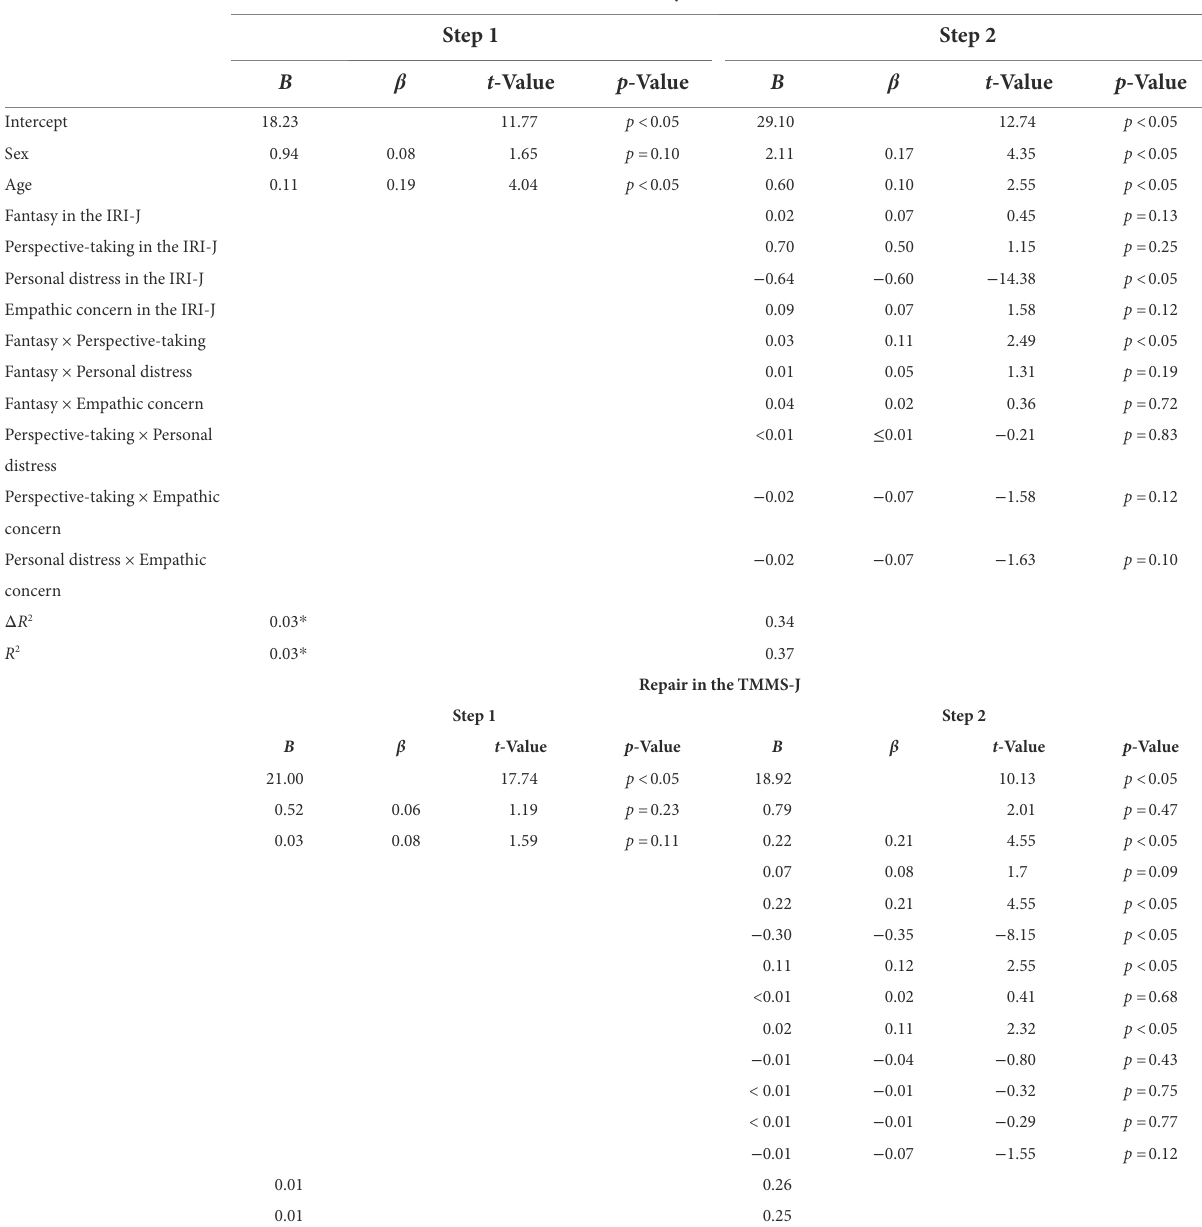
TABLE 2 Hierarchical multiple linear regression predicting clarity and repair in the TMMS-J from each subscale in the IRI-J ( N = 475). Clarity in the